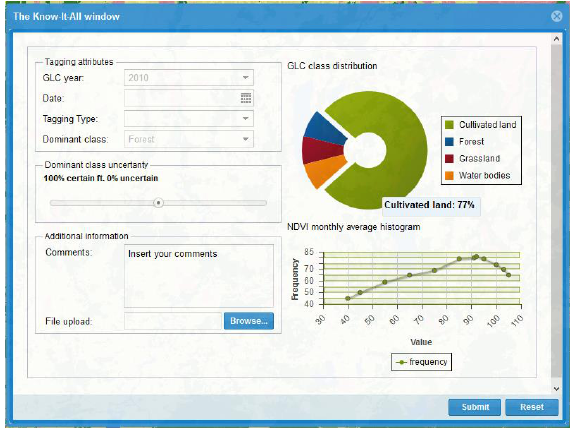
Figure 2. User contribution form